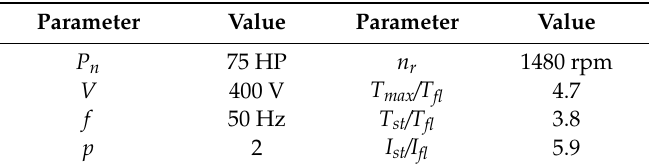
Table 14. Data of Machine 3 [64].